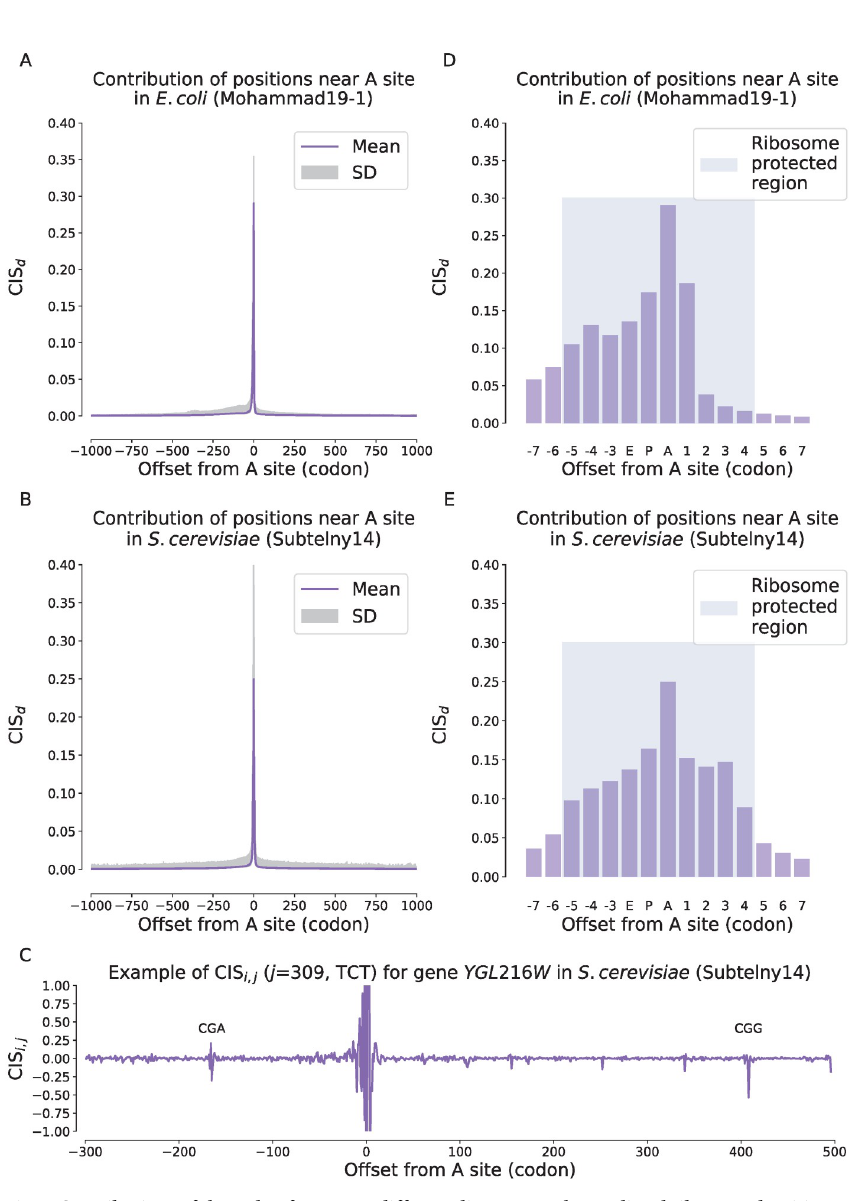
Fig 2. Contributions of the codon features at different distances to the predicted ribosome densities measured by the codon impact score (CIS) on the Mohammad19-1 ( E.coli ) (A and D) and the Subtelny14 ( S.cerevisiae ) (B and E) datasets. (A–B). The average contributions of input codons to the predicted ribosome density of current codon with respect to the relative distances on the Mohammad19-1 (A) and the Subtelny14 (B) datasets. The horizontal axis stands for the offset from the input codon to the A site of current codon, where a positive value stands for the 3 0 direction while a negative value stands for the 5 0 direction. The solid line refers to the average CIS d values while the shaded region stands for the scope of one standard deviation. (C). Case study for gene YGL216W in S.cerevisiae of the Subtelny14 dataset, in which the CIS i , j values of different positions with respect to the predicted ribosome density of the codon at position j = 309 are shown. The horizontal axis is the offset of the codon at position i relative to the codon at position j = 309. (D–E). The zoomed-in contributions of those codons near the ribosomal A sites on the Mohammad19-1 (D) and the Subtelny14 (E) dataset. The blue shaded regions in (D) and (E) stand for the ribosome protected regions of the mRNA sequence.